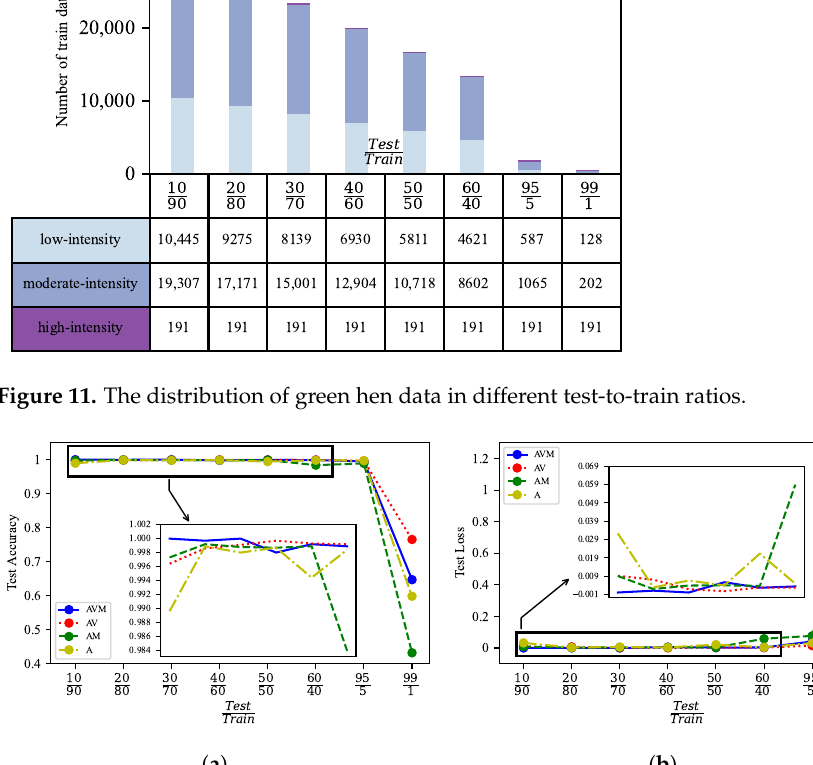
Figure 12. LeNet5 test accuracy ( a ) and loss ( b ) vs. test-to-train ratios for different data bundles of the green hen